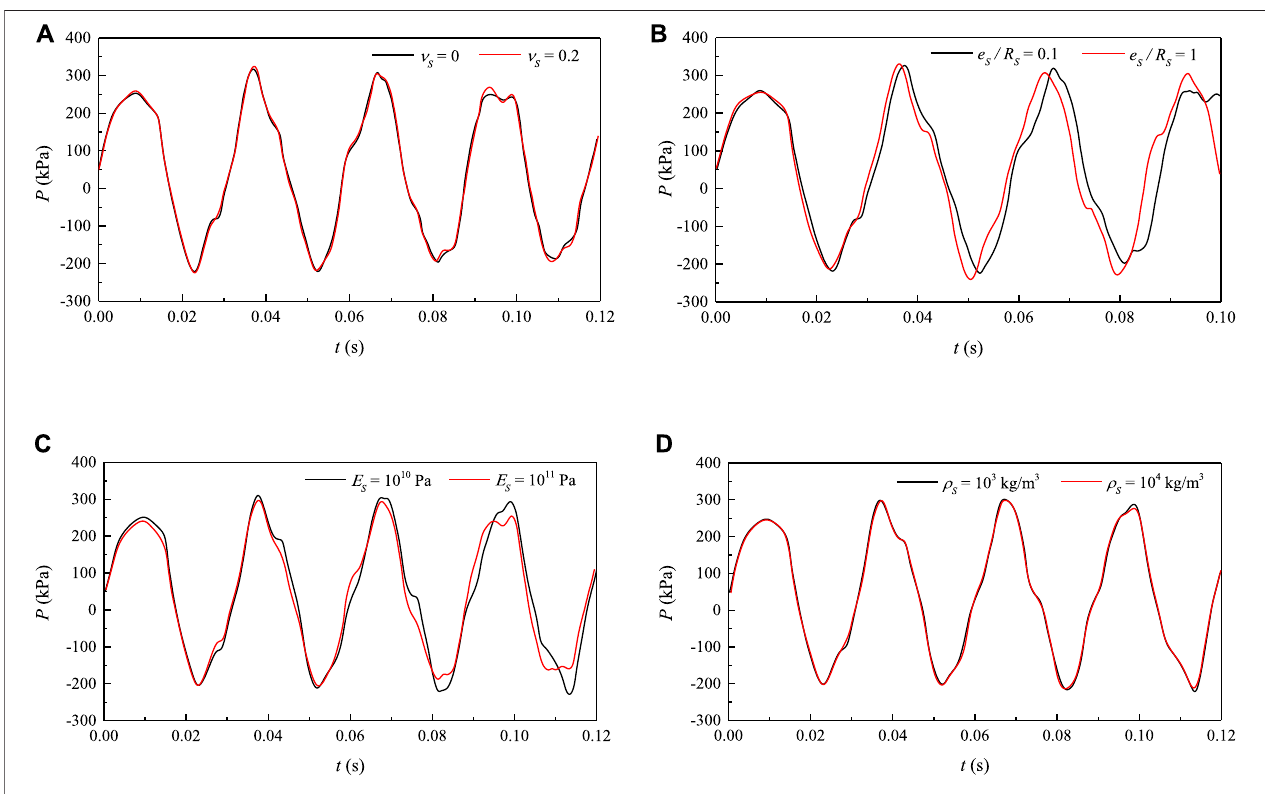
FIGURE 9 | Dynamic pressure varies with the parameters of concrete (A) Poisson ’ s ratio. (B) Thickness-radius ratio. (C) Elastic modulus. (D) Density.